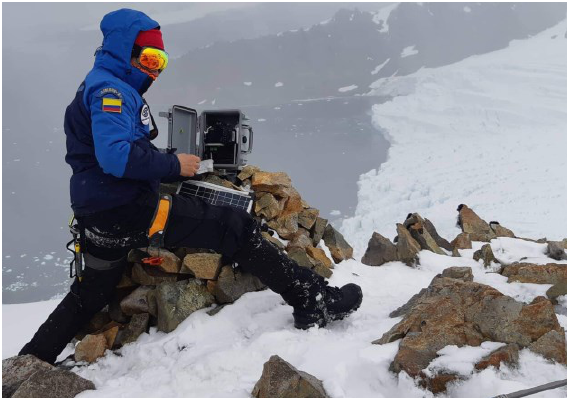
Figure 3: Camera installation at Lange Glacier